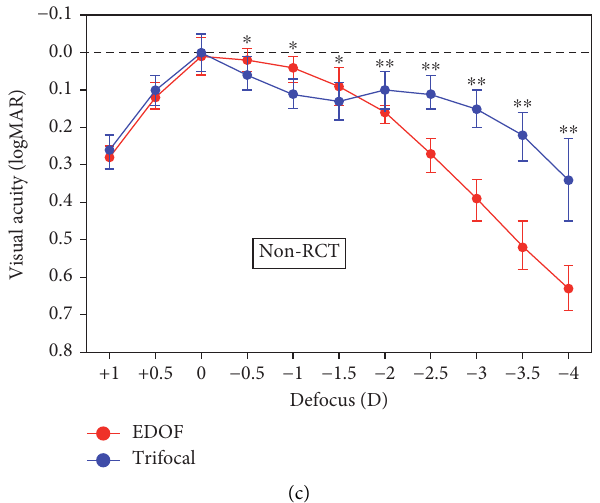
Figure 6: (a) The overall defocus curve; (b) the defocus curve synthesized from randomized controlled trials (RCTs); and (c) the defocus curve synthesized from prospective comparative studies. The bar represents the standard deviation. ∗ P < 0 . 05, ∗∗ P < 0 . 01. EDOF, extended depth-of-focus.